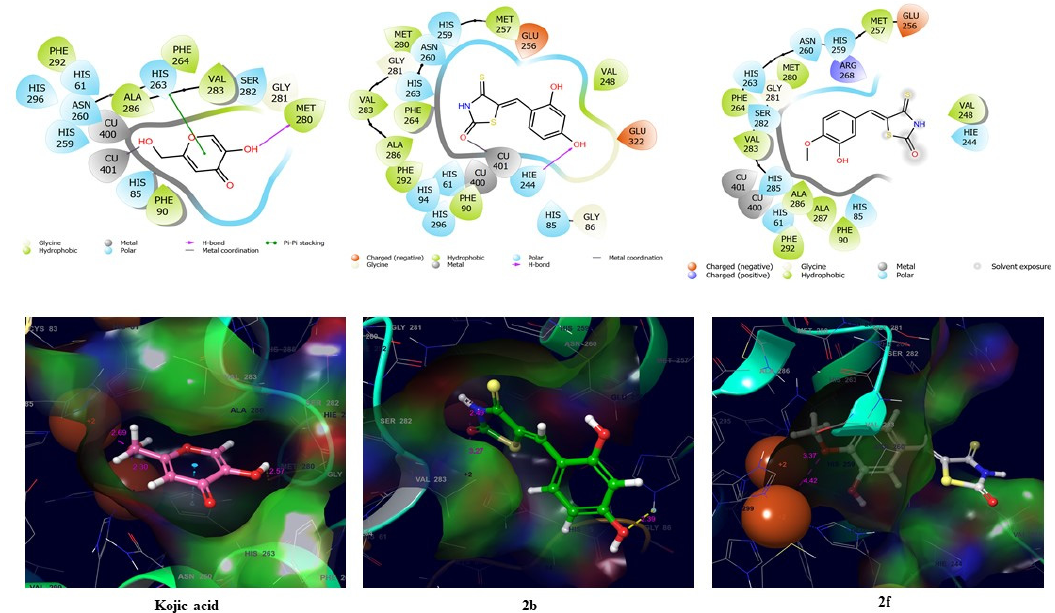
Figure 5. Docking studies on compounds 2b and 2f and kojic acid using Schrödinger Suite. m TYR ( Agaricus bisporus tyrosinase, PDB ID = 2Y9X) was used as the tyrosinase for docking simulations. Pharmacophore results for 2b , 2f , and kojic acid are represented in 2D and 3D conformations.